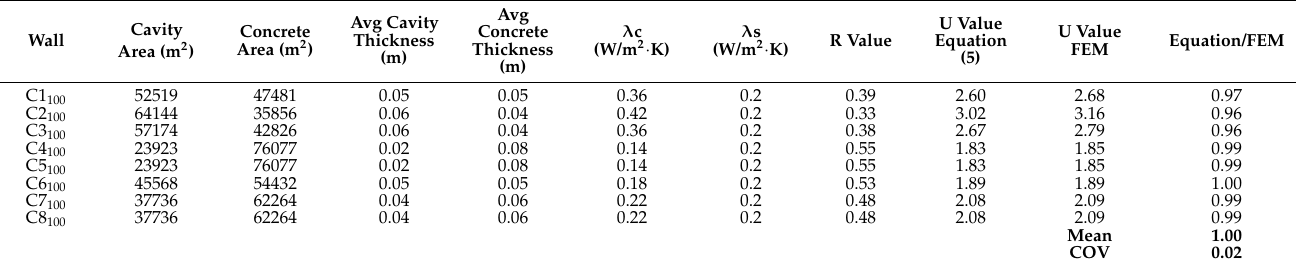
Table 8. Comparison of